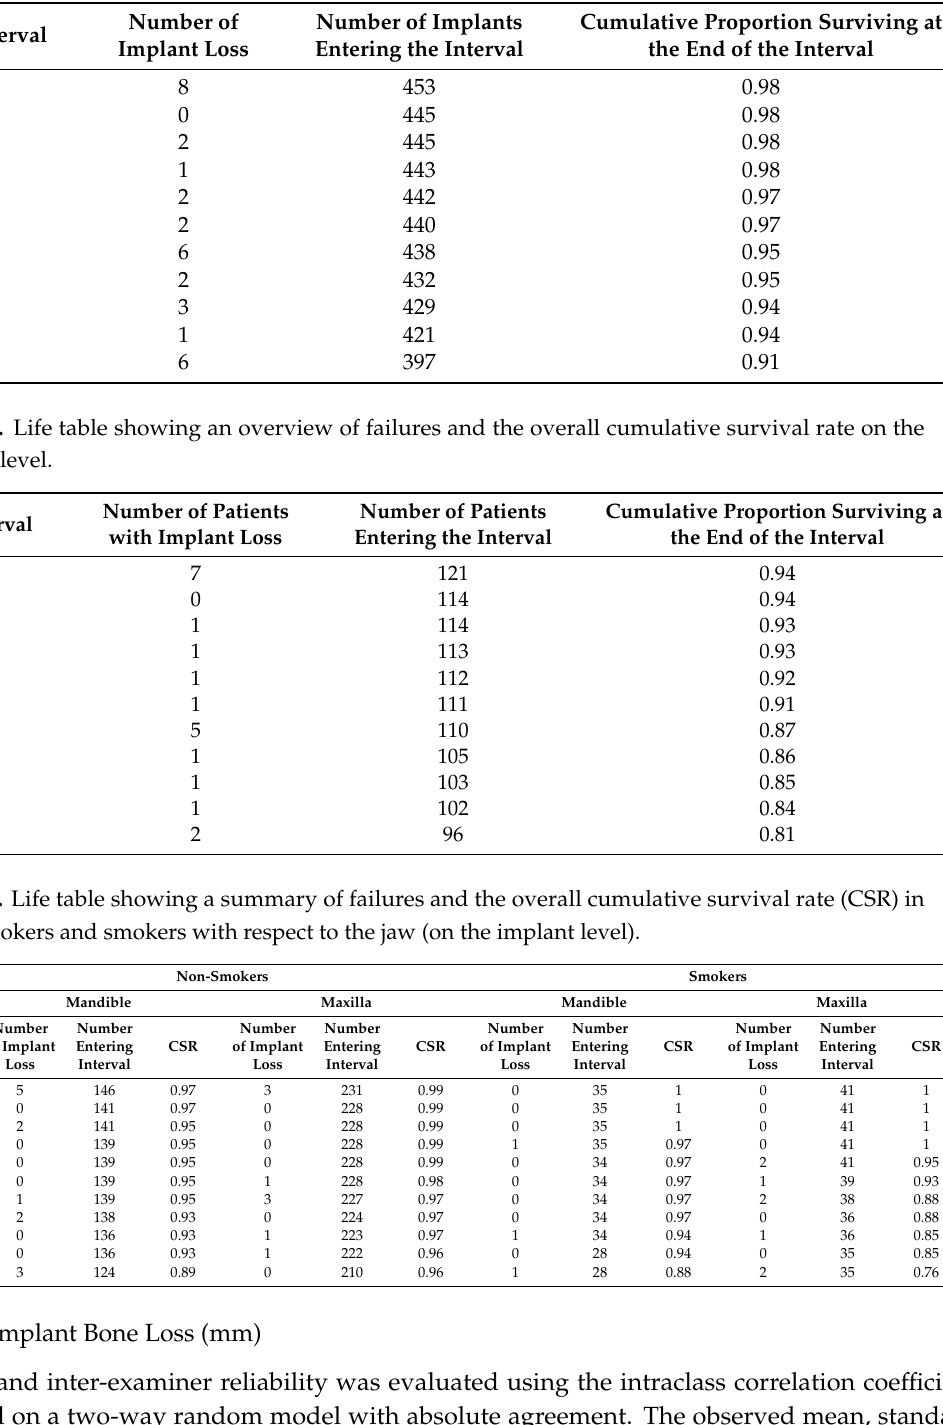
Table 1. Life table showing an overview of failures and the overall cumulative survival rate on the implant level.